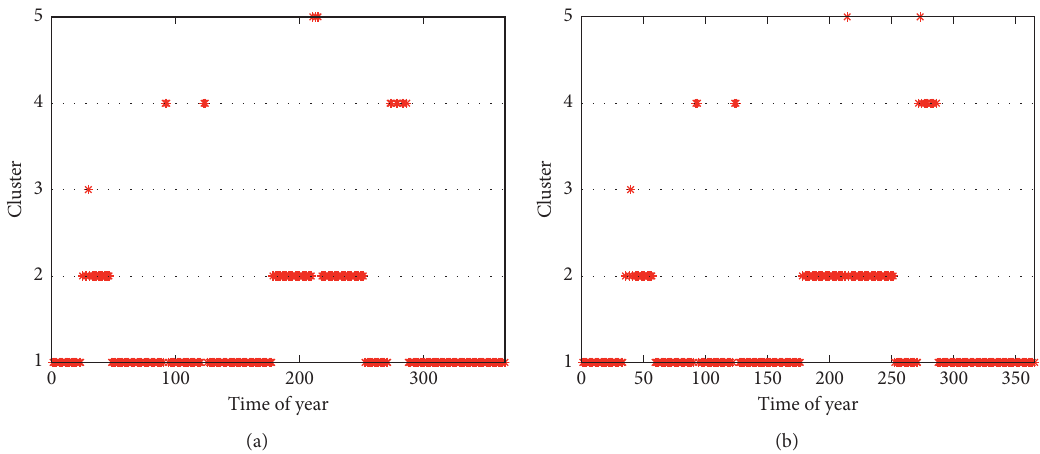
Figure 5: Passenger operation time interval classification results: (a) classification results in 2014; (b) classification results in